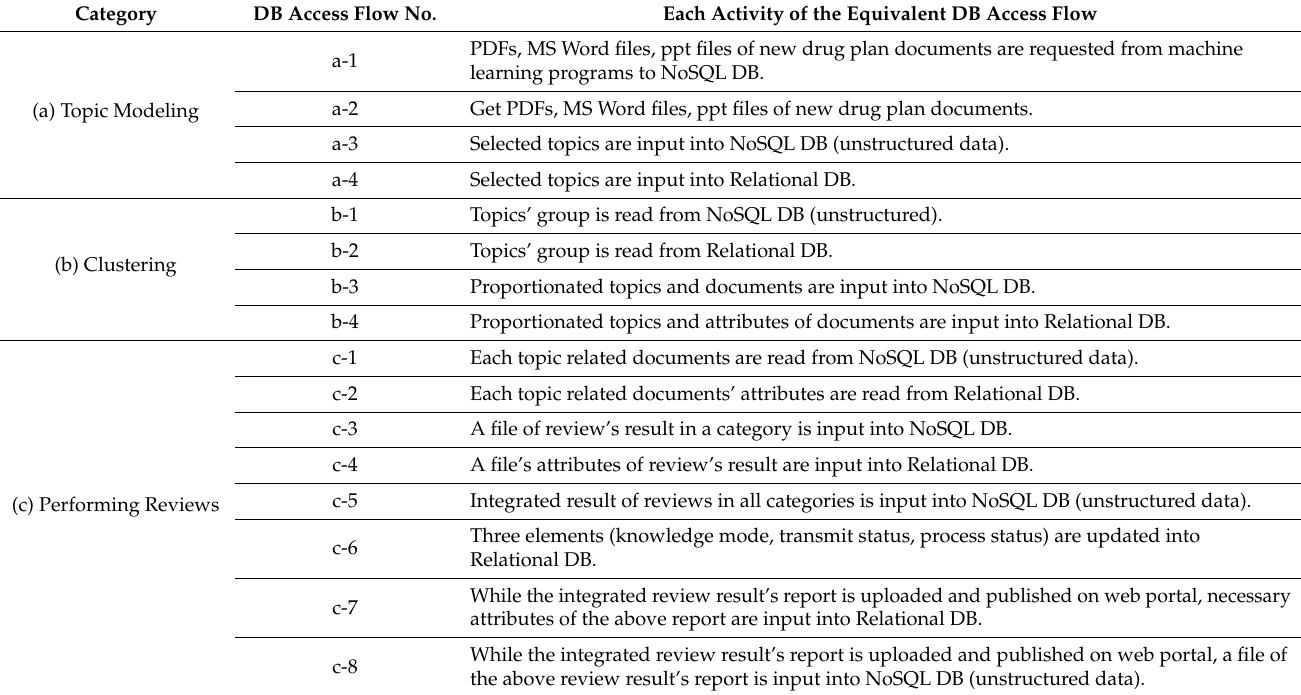
Table 3. Each activity of the equivalent DB access flow in new drug development review system. Category DB Access Flow No. Each Activity of the Equivalent DB Access